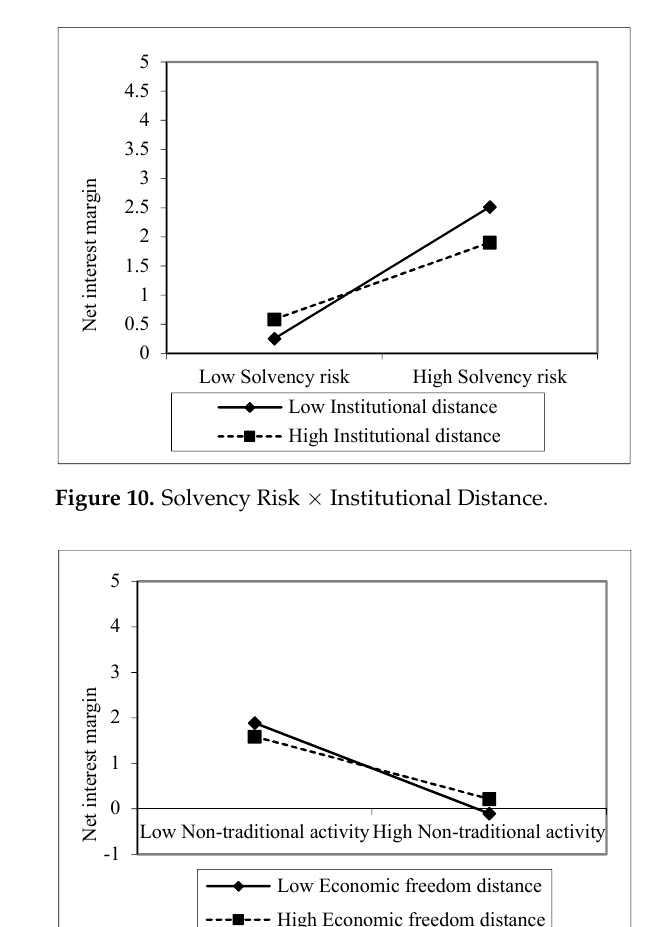
Figure 9. Credit Risk × Institutional Distance.